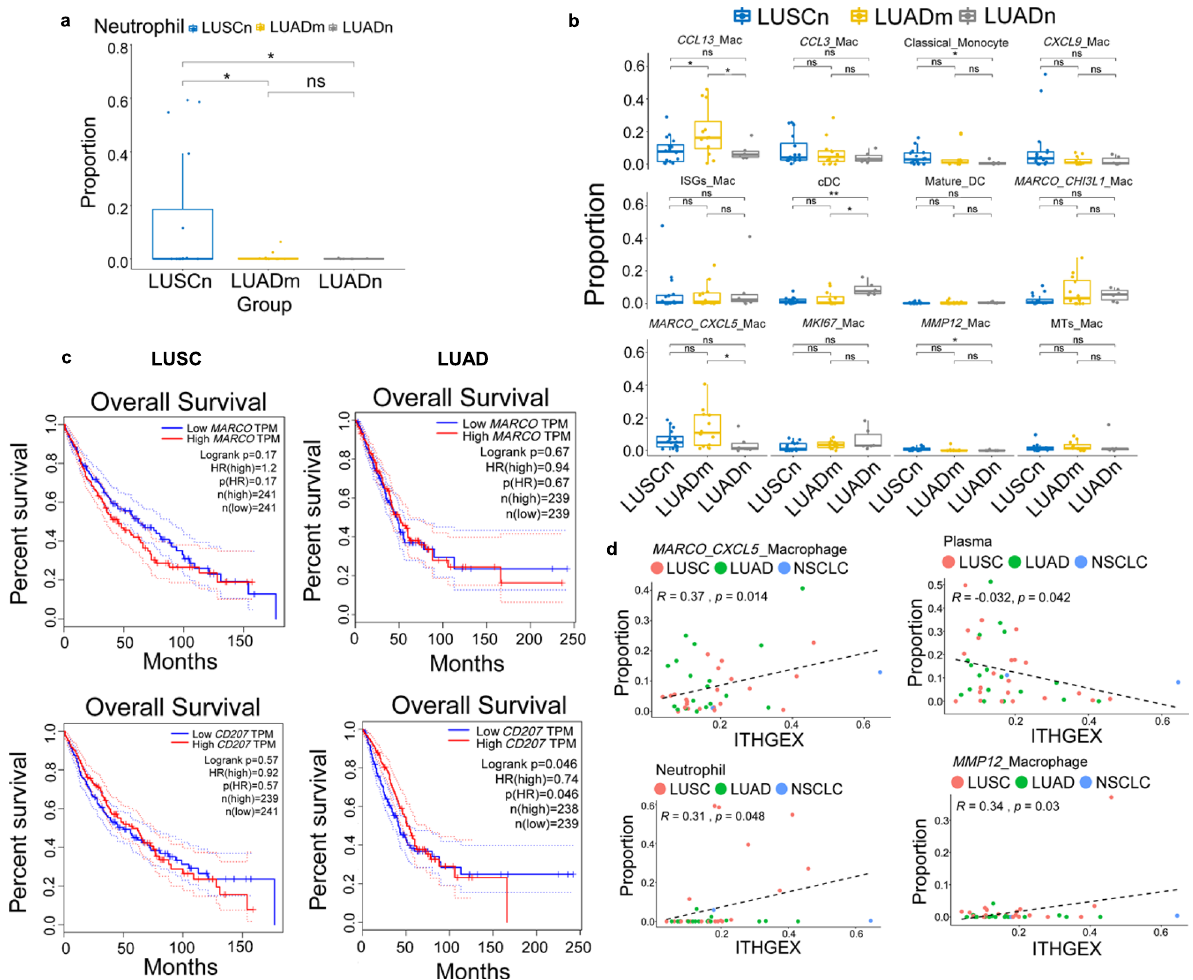
Fig. 5 Correlation analysis of cellular composition, tumor subtypes, and ITH. Cellular composition analysis of cell type between patient groups for a neutrophils and b macrophage subtypes. Two-sided unpaired Wilcoxon test was performed to compare between groups for tests in a and b (LUSCn: n = 16, LUADn: n = 6, LUADm: n = 12 for both a and b . ** p ≤ 0.01; * p ≤ 0.05; ns: p > 0.05). The lower hinge, middle line, and upper hinger of boxplots represented the fi rst, second, and third quartiles of the distributions. The upper and lower whiskers corresponded to the largest and smallest data points within the 1.5 interquartile range. All actual data values were also plotted as dots alongside the boxplots. c Survival analysis for tissue-resident macrophage markers ( MARCO and CD207 ) of LUAD and LUSC. d Correlation analysis between ITH GEX and the cellular composition of patients. Only signi fi cantly associated cell types were shown. The tumor subtypes (LUAD, LUSC, and NSCLC) were shown in different colors and p -values were obtained by two-side t -tests (LUAD: n = 18, LUSC: n = 22, and NSCLC: n